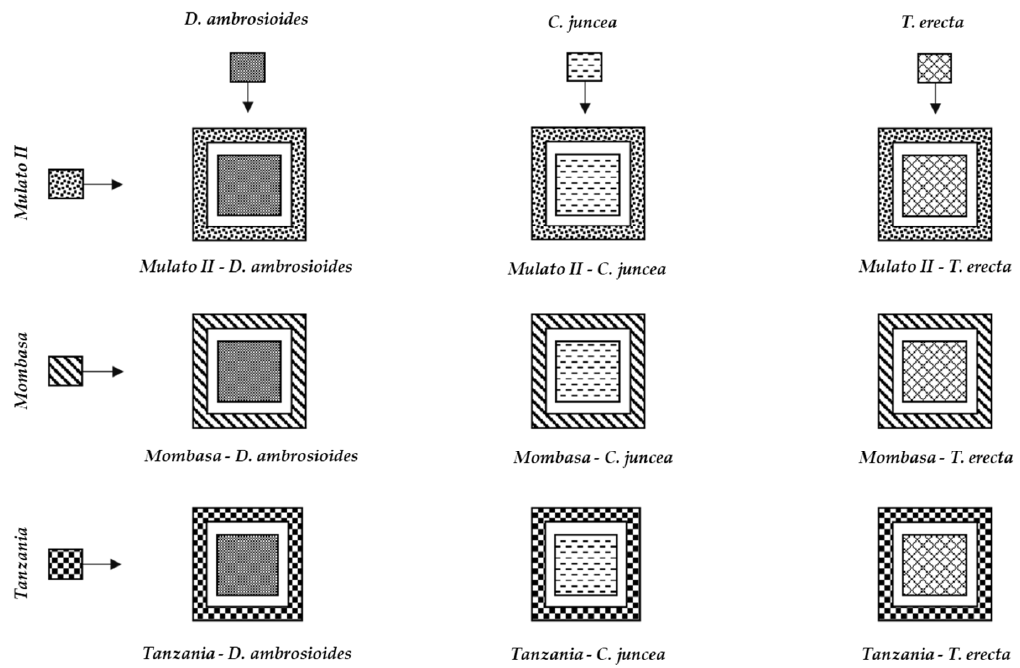
Figure 10. Proposed push–pull strategies for fall armyworm management in maize crops in Yautepec, Mor., Mexico.